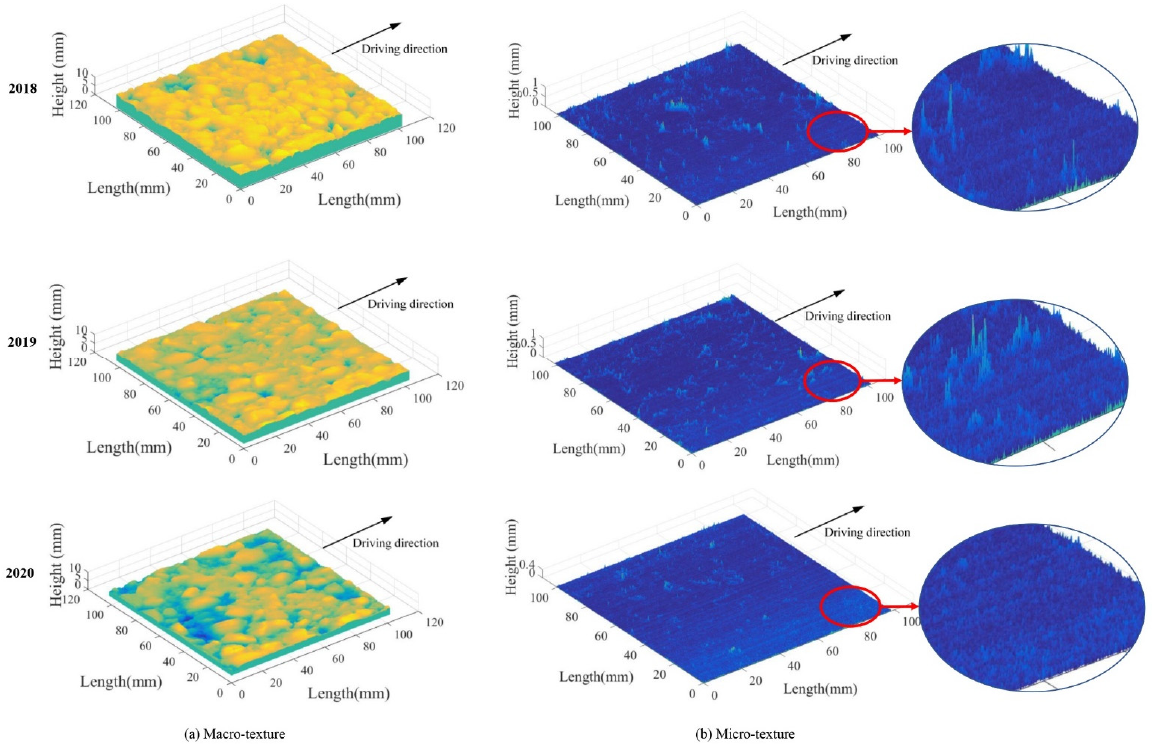
Figure 3. Evolution of pavement micro- and macro-texture: ( a ) Macro-texture, and ( b ) Micro-texture.